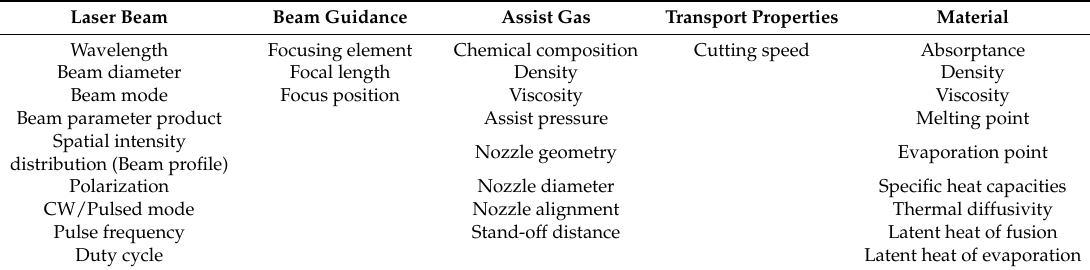
Table 1. Processing parameters related to the dynamics of the laser cutting processes